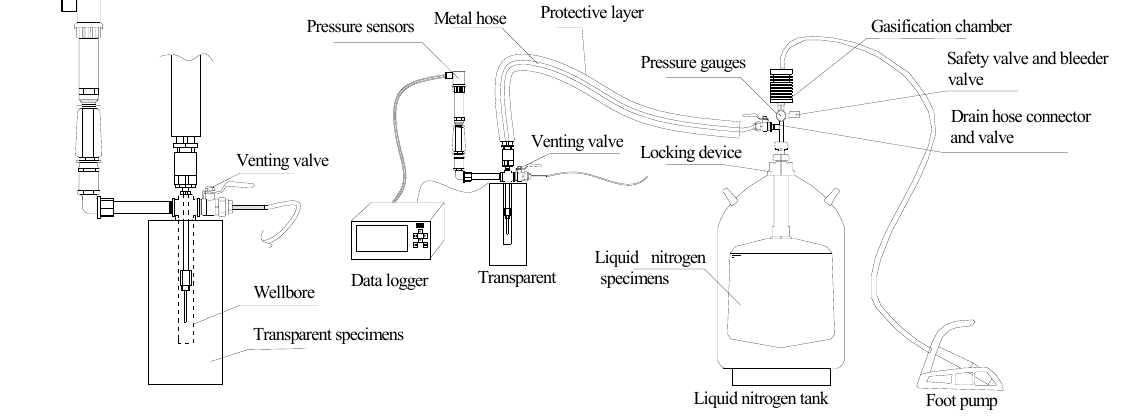
Figure 3. Low-pressure impact path of liquid nitrogen.